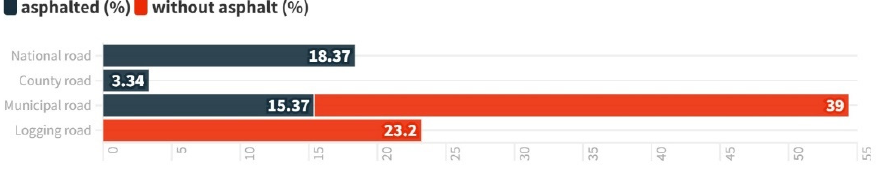
Figure 4. Quality of the road network in Sucevi ț a and Marginea villages.